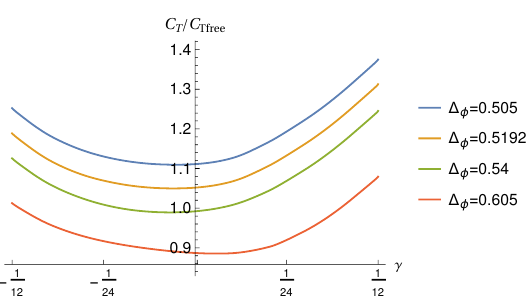
Figure 13 . Lower bound on the central charge normalized to the central charge of a free complex boson as a function of the parameter γ at fixed values of ∆ φ assuming that the scalar φ is neutral under the symmetry generated by the current J . The bounds have been obtained at Λ = 13